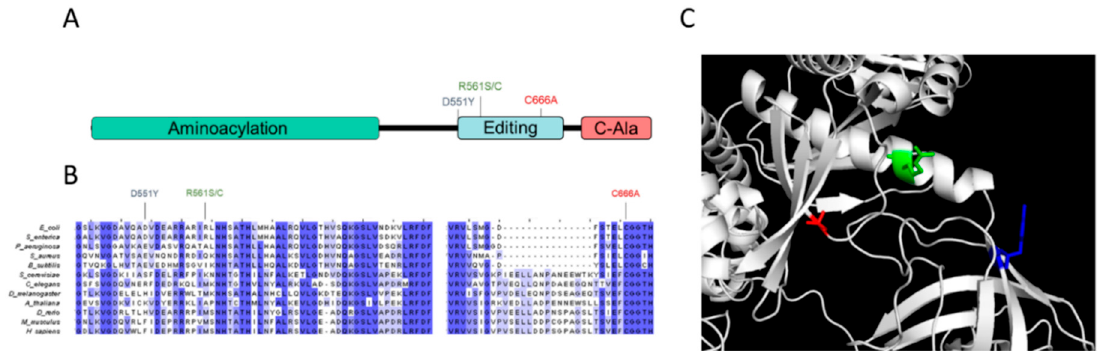
Figure 1. AlaRS C666A suppressors map to the AlaRS proofreading domain. ( A ) Suppressor mutations map to the AlaRS proofreading domain. ( B ) The sites for suppressor mutants do not appear to be conserved across all domains of life. ( C ) Suppressor variants were modeled on the AlaRS proofreading domain using Phyre2 (96% of residues modeled at > 90% accuracy).